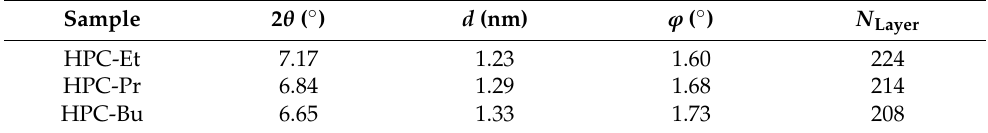
Table 2. Experimental results of WAXD measurements of HPC-Et, HPC-Pr, and HPC-Bu at the temperature where the HPC derivatives showed a reflection peak at 405 nm. The distance ( d ) and the twisting angle ( ϕ ) between two adjacent layers, and the number of layers in one pitch ( N Layer ) of each sample were determined using 2 θ values obtained from the WAXD measurements. Sample 2 θ ( ◦ ) d (nm) ϕ ( ◦ ) N Layer HPC-Et 7.17 HPC-Pr HPC-Bu 6.65